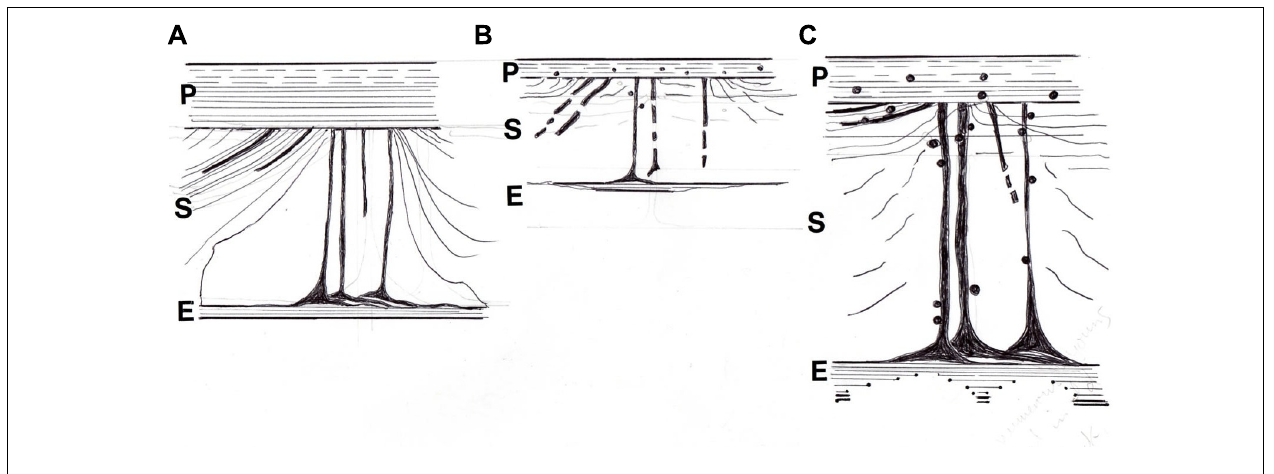
FIGURE 6 | Diagram of the postulated periosteal-Sharpey’s fiber-endosteal (PSE) integrated system. (A) In youth when it is multiaxial and pervasive with oblique insertions predominant and with a well defined CIII-rich endosteal rim. (B) With age and osteoporosis when insertions are more polarized horizontally, with general signs of regression and fragmentation, and with a discontinuous CIII-rich endosteal rim; also associated are sparsely distributed fine mineral